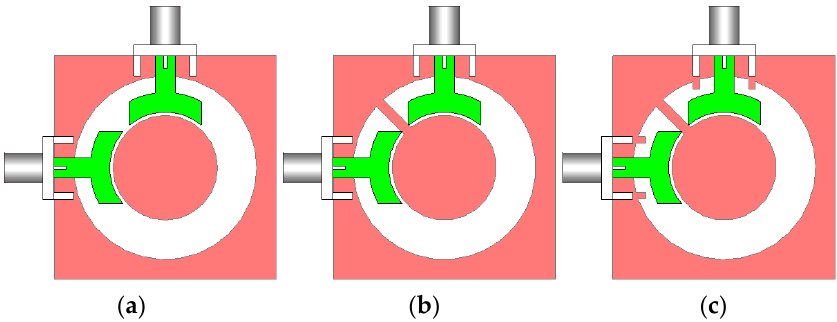
Figure 2. Various structures of the UWB slot antenna, ( a ) antenna with a circular-ring slot radiator, ( b ) the antenna with open-ended circular-ring slot, and ( c ) the proposed UWB antenna design.